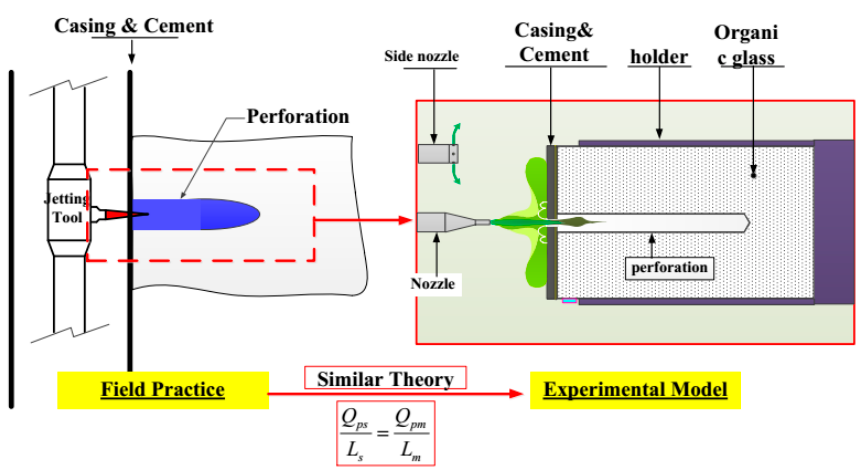
Figure 16. The similar Reynolds number between field practice and experiments.